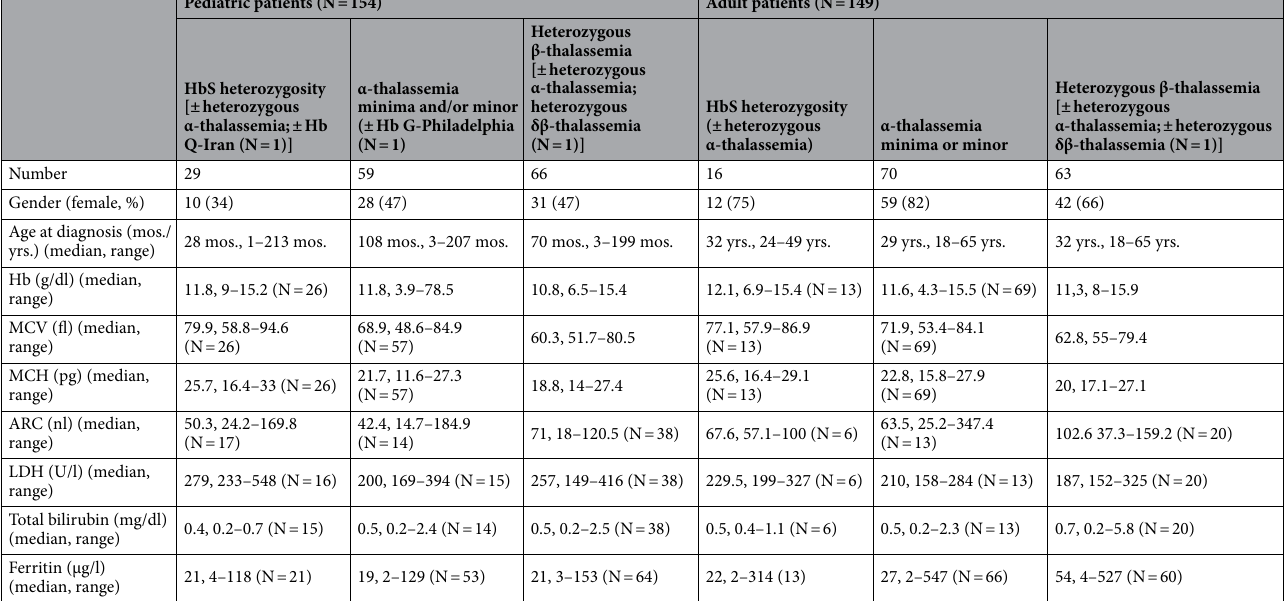
Table 2. Clinical data of pediatric and adult hemoglobinopathy carriers (N = 303). ARC absolute reticulocyte count, Hb hemoglobin, HPFH hereditary persistence of fetal hemoglobin, LDH lactate dehydrogenase, MCH